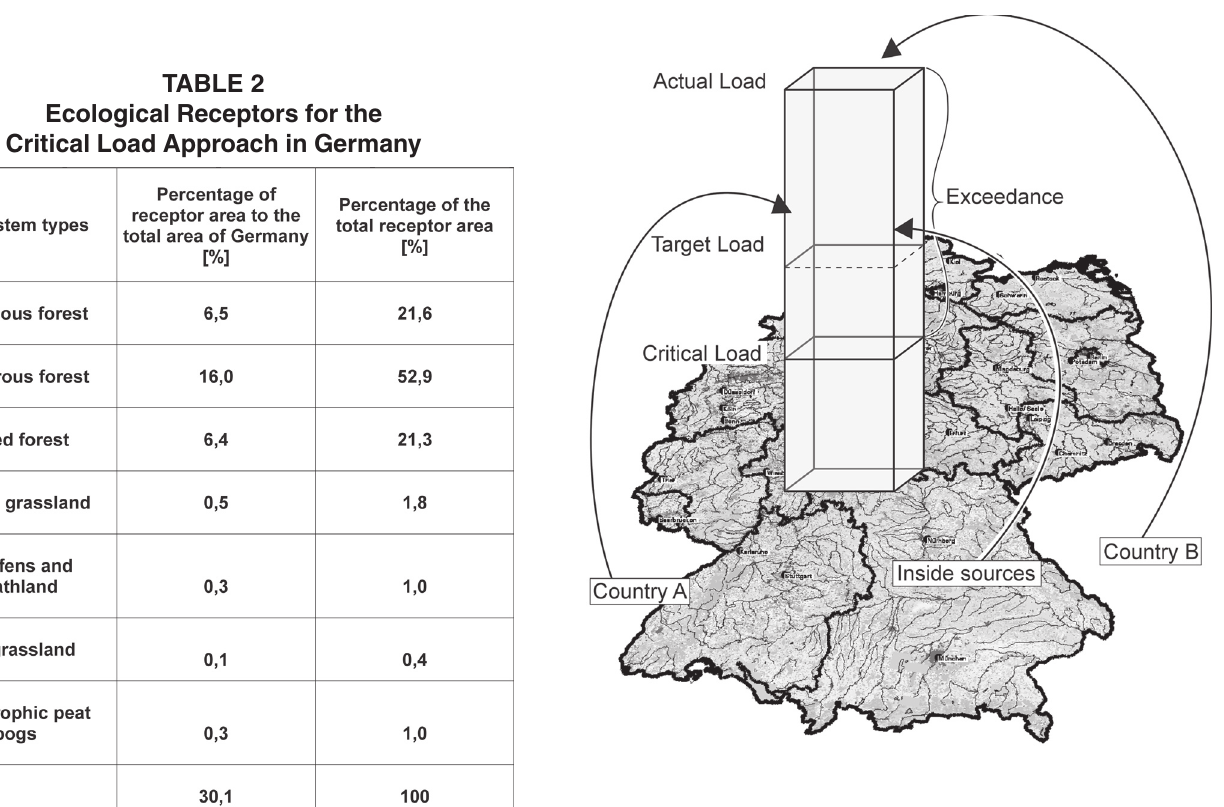
FIGURE 2 . The critical load